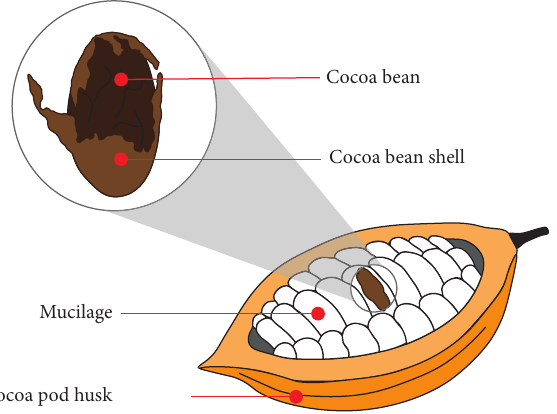
Figure 1: Cocoa industrial